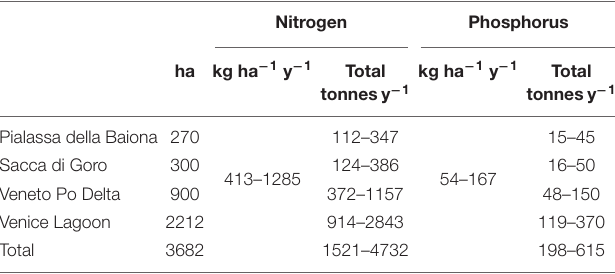
TABLE 4 | Estimate of the potential nutrient removal by macroalgal harvesting taking into account the mean nutrient concentrations. Nitrogen